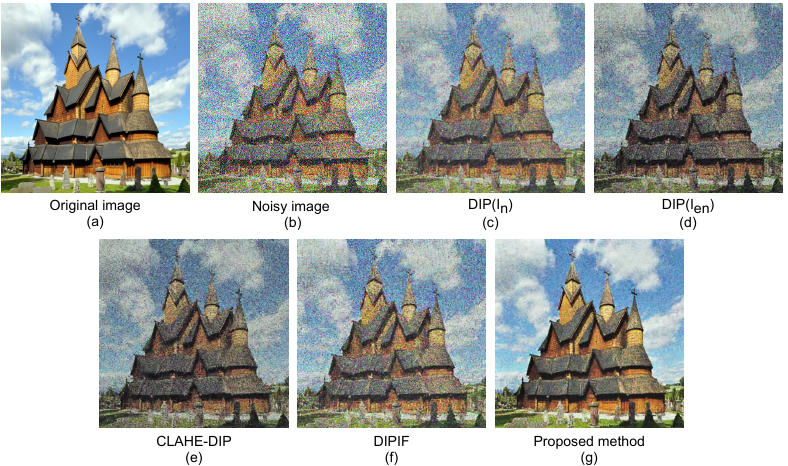
Figure 7. Noise-free images produced by our proposed method and competitive denoising methods on a “house” image with 70% noise corruption. ( a ) Clean image, ( b ) noisy image I n , ( c ) image restored by the DIP method using the original noisy image I n for supervision, ( d ) image restored by the DIP method using enhanced noisy image I en for supervision, ( e ) image restored by the CLAHE-DIP method, ( f ) image restored by the DIPIF method, and ( g ) image restored by our proposed